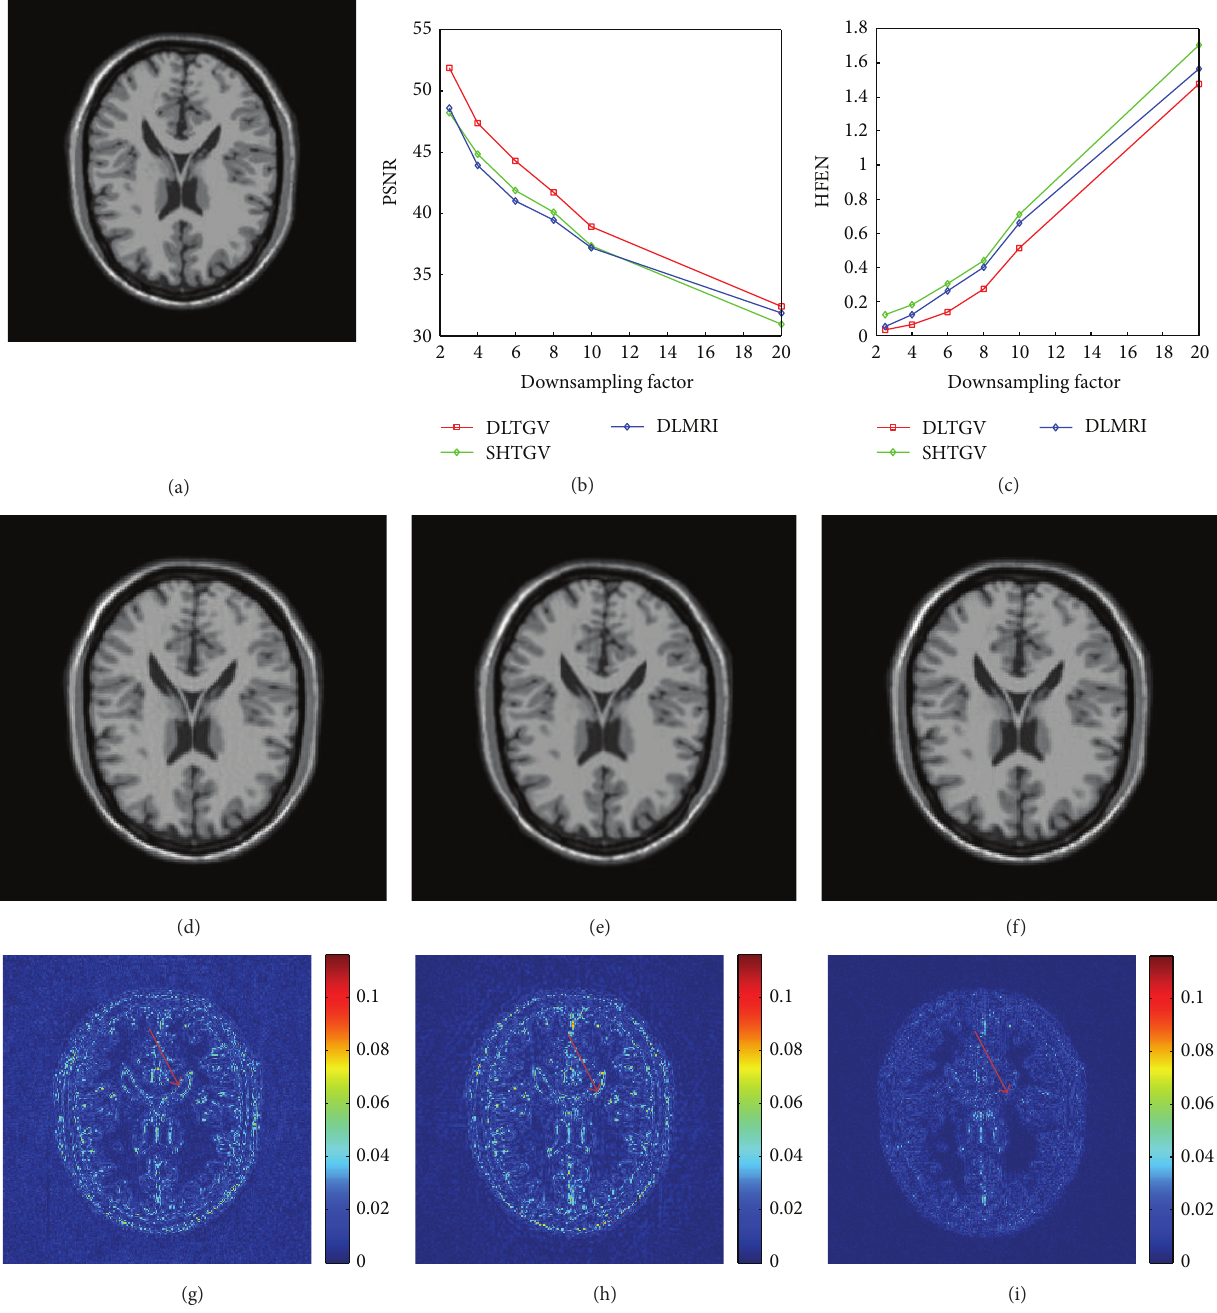
Figure 1: (a) The reference image. ((b), (c)) The PSNR and HFEN versus the downsampling factor. ((d), (e), (f)) The reconstruction results under pseudo radial sampling trajectory of DLMRI, SHTGV, and DLTGV. ((g), (h), (i)) The corresponding reconstruction error magnitudes of (d), (e), and (f).